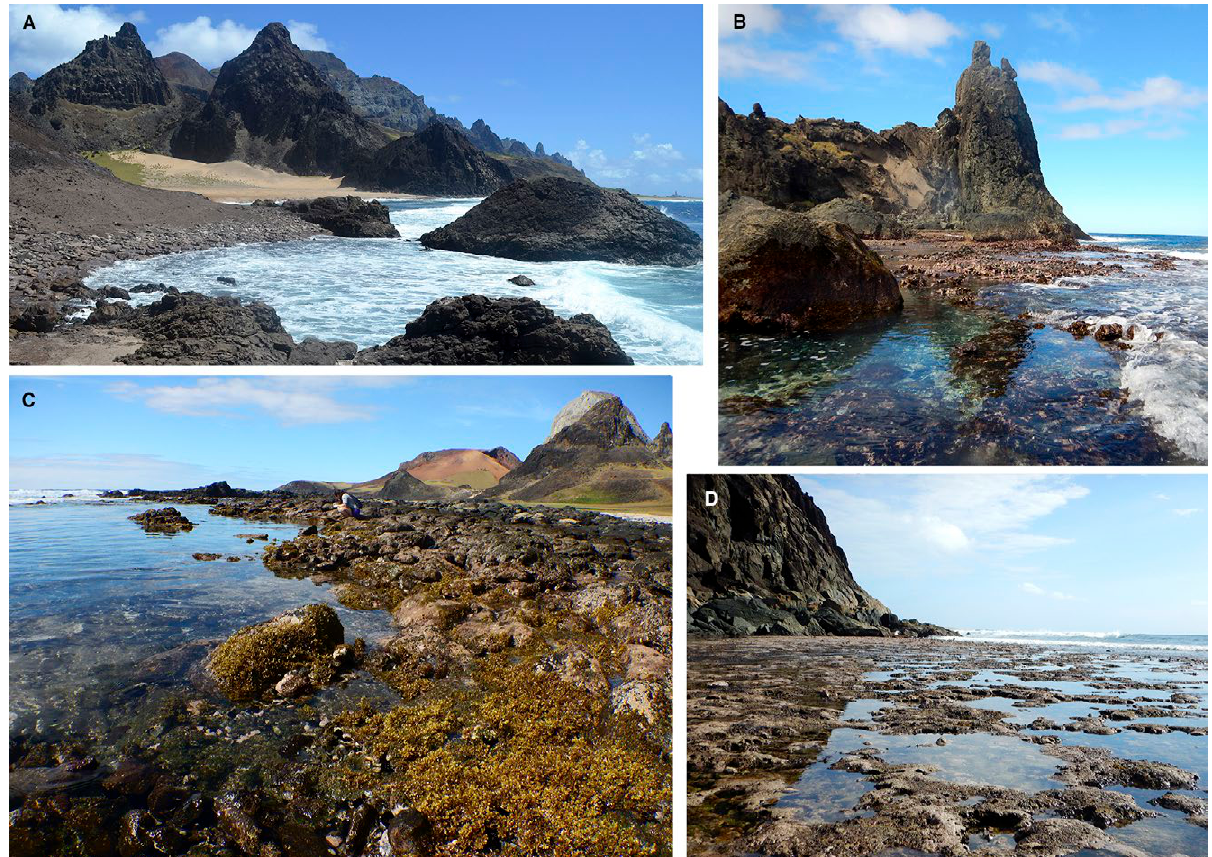
Fig. 2. – Trindade island. A, Parcel and Tartarugas Beach; B, Cachoeira tide pools; C and D, Andradas and Tartarugas